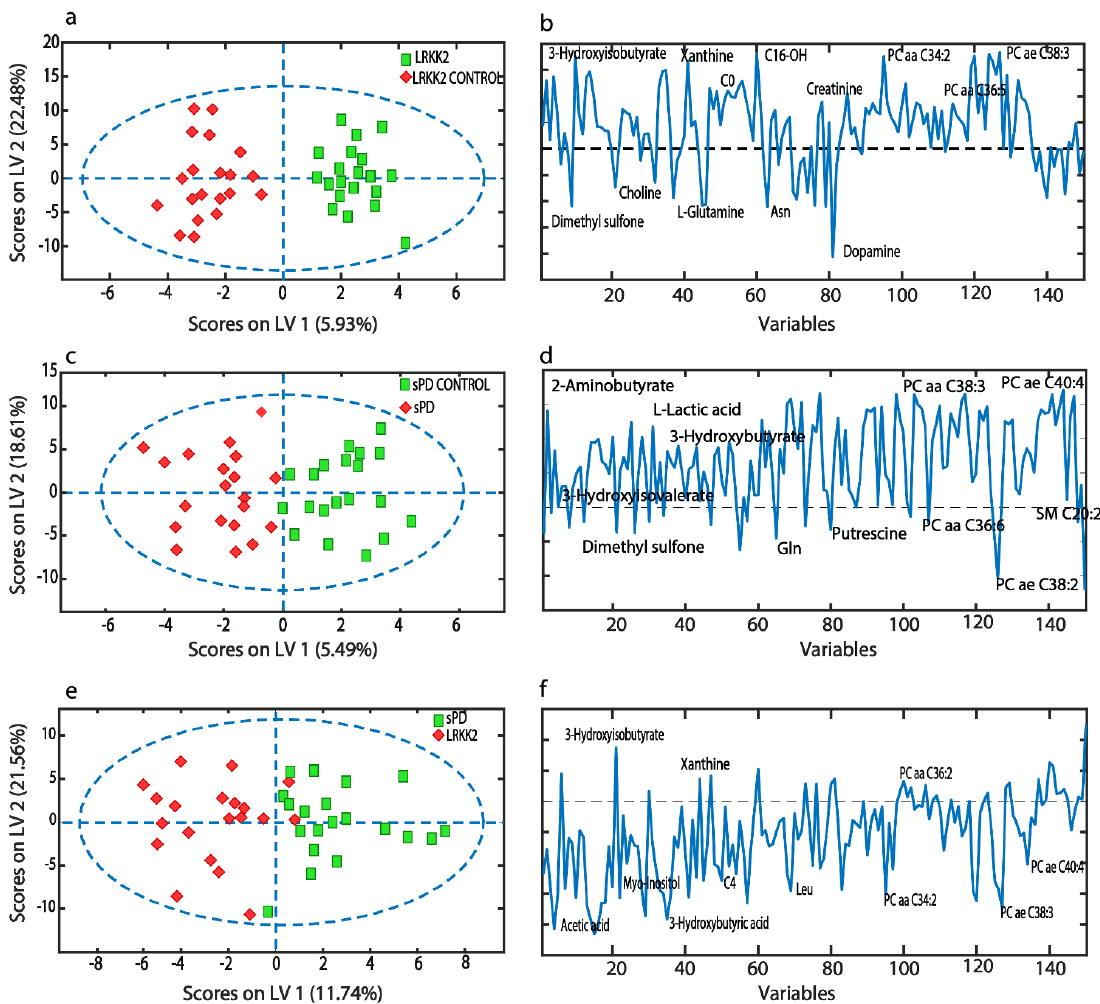
Figure 1. ( a ) The O-PLS-DA score plot of LRKK control vs. LRRK2 sufferers; ( b ) top 13 metabolites on loadings driving the separation; ( c ) O-PLS-DA score plot of sporadic Parkinson’s disease (sPD) controls vs. sPD sufferers; ( d ) top 13 metabolites on loadings driving the separation; ( e ) the O-PLS-DA score plot of sPD vs. LRKK2 sufferers; ( f ) top 13 metabolites on loadings driving the separation.